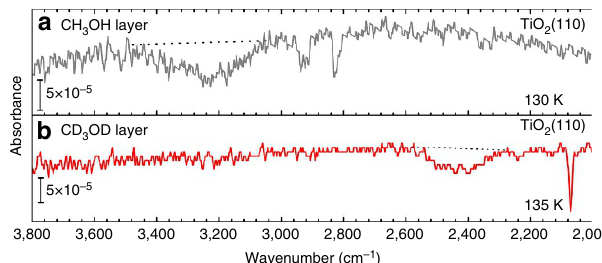
Figure 4 | IR reflectance-adsorption spectra. ( a ) Methanol (CH 3 OH) and ( b ) deuterated methanol (CD 3 OD) adsorbate layer on the rutile TiO 2 (110)